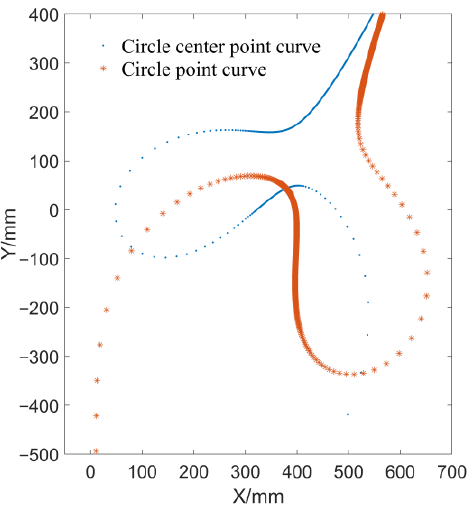
Figure 11. Circle center point curve and circle point curve of the 3R open chain. A group of solutions is selected from Figure 10 and Figure 11, respectively, to form a five-bar linkage. The coordinates of the fixed hinge joint (point 2 ) of five-bar linkage are (−137.16, −120.75). The coordinates of point A are (49.31, −23.96), the coordinates of point B are (18.13, −276.35) and the coordinates of point C are (−69.37, −169.34). The length of each bar of the five-bar linkage can be further obtained: